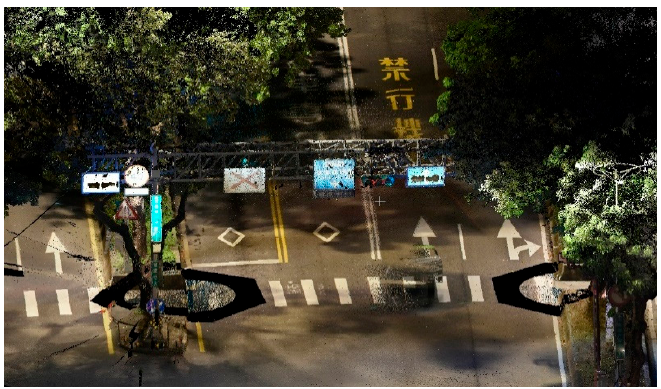
Figure 2. Color point cloud reconstruction by a RIEGL 3D Terrestrial Laser Scanner [3].